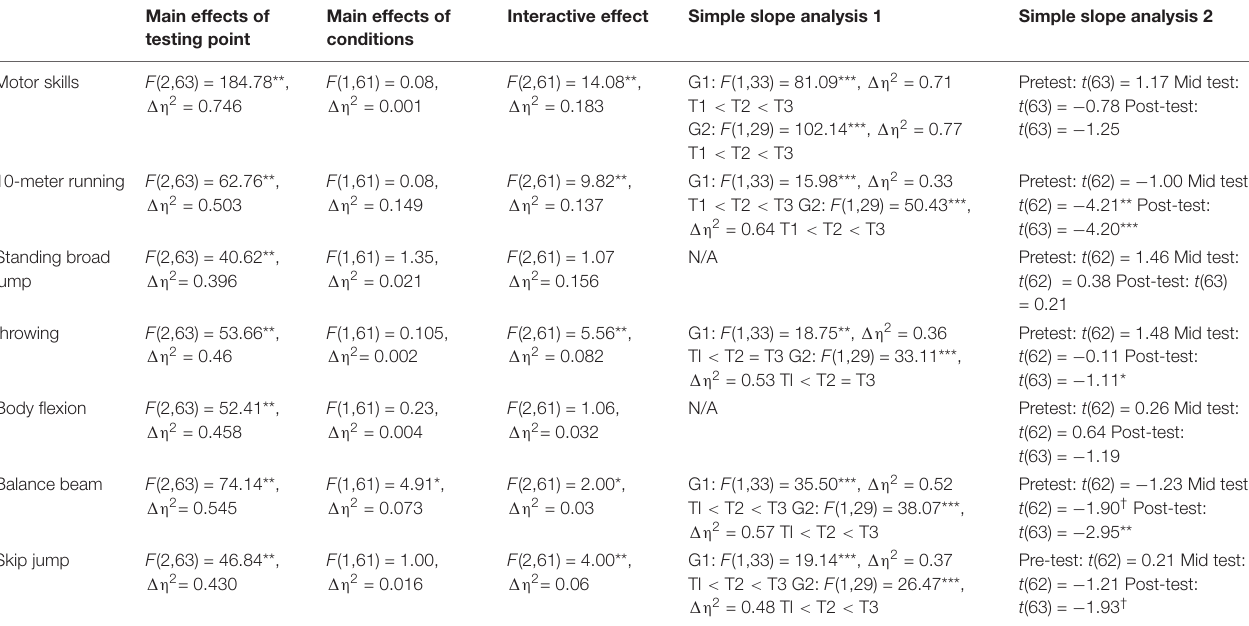
TABLE 3 | The effects of the group-play MVPA intervention program on motor skills and its